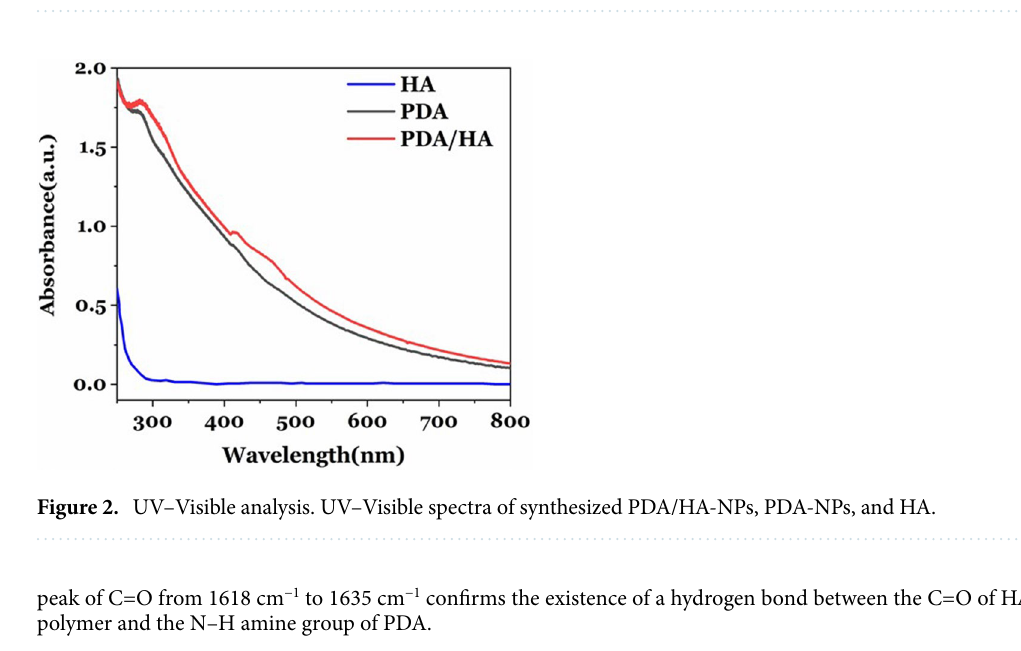
Figure 1. PDA/HA/GD3 + image. ( a ) The synthesis procedure of Gd 3+ -dual contrast agent. ( b ) The chemical structure of prepared Gd 3+ -loaded PDA/HA-NPs.